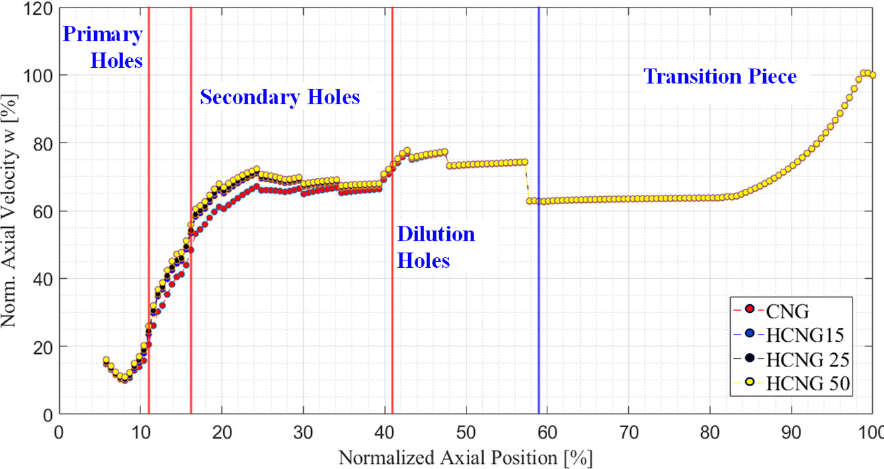
Figure 10. Normalized mass-averaged axial velocity as a function of the axial position in the basket.